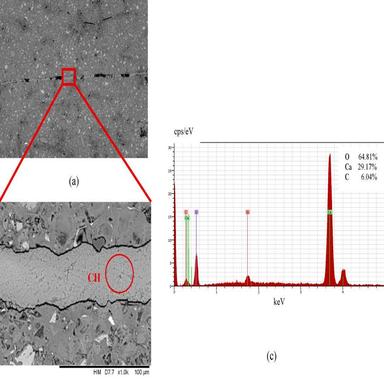
Sample with 2% CA: (a) SEM micrograph (BSE image) of the polished section showing a crack with healing products; (b) Region outlined by the red rectangle in (a) imaged in higher magnification; (c) EDS microanalysis (spectrum and quantification of elements above 1%) of the region pointed out by the red circle, identified as CH. (For interpretation of the references to colour in this figure legend, the reader is referred to the Web version of this article.)